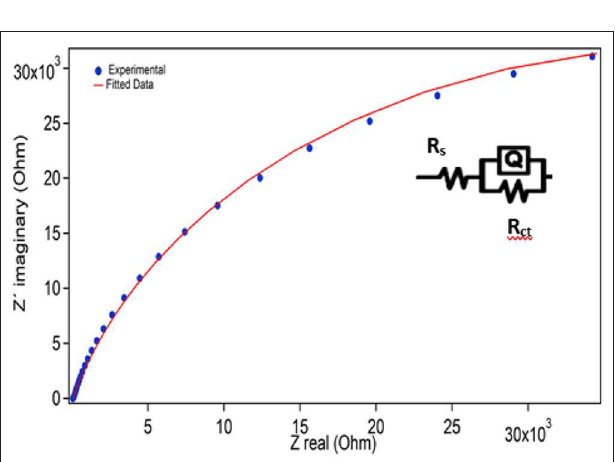
equivalent circuit, R s , Q, and R ct represent solution resistance, phase constant and charge resistance, respectively. The charge transfer resistance indicates that the deposition of SnS